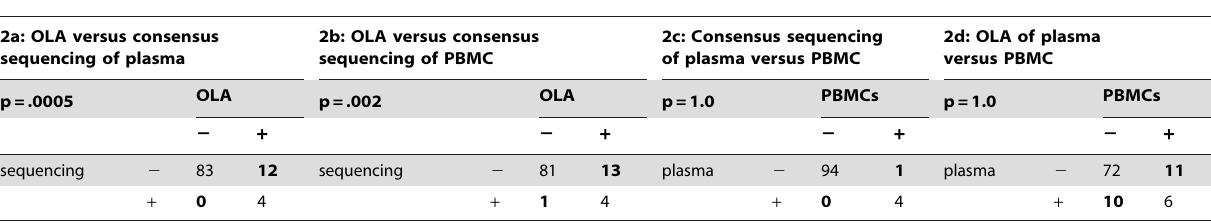
Table 2. HIV-1 drug resistance in ARV-naı¨ve subjects with primary HIV-1 infection.